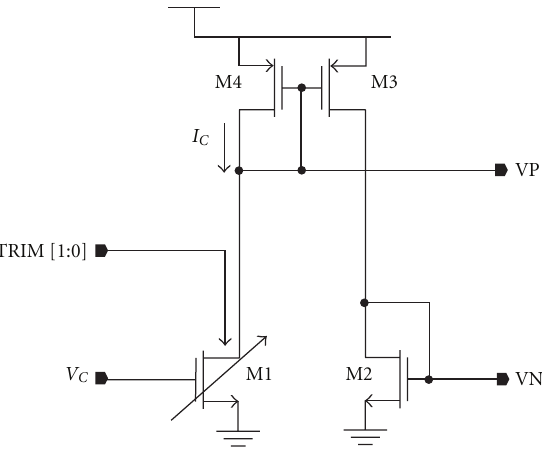
Figure 13: Circuit diagram of